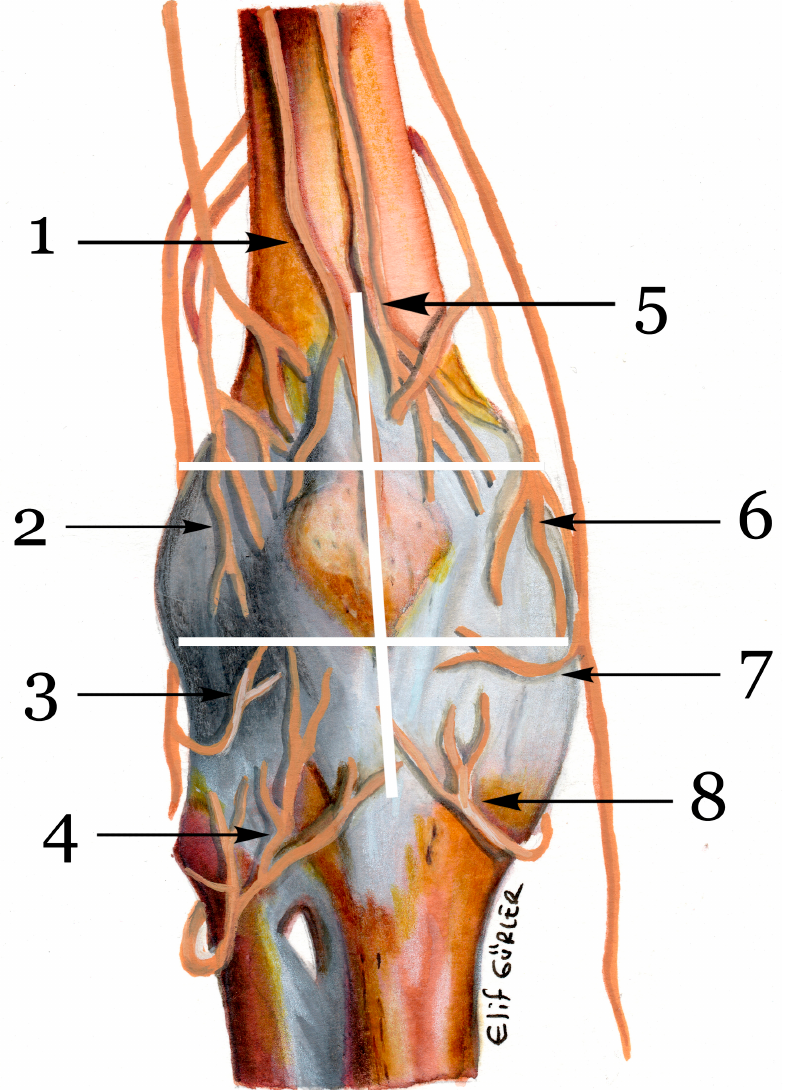
Figure 2. Sensorineural anatomy of knee . Note 1. lateral branch of nerve to vastus inter- medius (LBNVM), 2. nerve to vastus lateralis (NVL), 3. inferolateral genicular nerve (LBNVM), 2. nerve to vastus lateralis (NVL), 3. inferolateral genicular nerve (ILGN), 4. recurrent (ILGN), 4. recurrent fibular nerve (RFN), 5. nerve to vastus medialis (NVM), 6. superome- fibular nerve (RFN), 5. nerve to vastus medialis (NVM), 6. superomedial geniculate nerve dial geniculate nerve (SMGN), 7. infrapatellar branch of saphenous nerve (IPBSN), 8. in- feromedial geniculate nerve (IMGN).